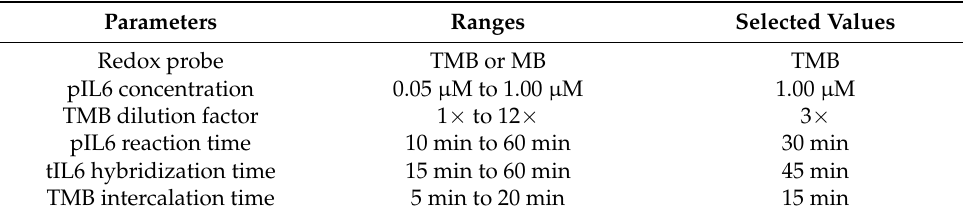
Table 2. Examined ranges influencing the analytical signal and the selected optimal values for this work.